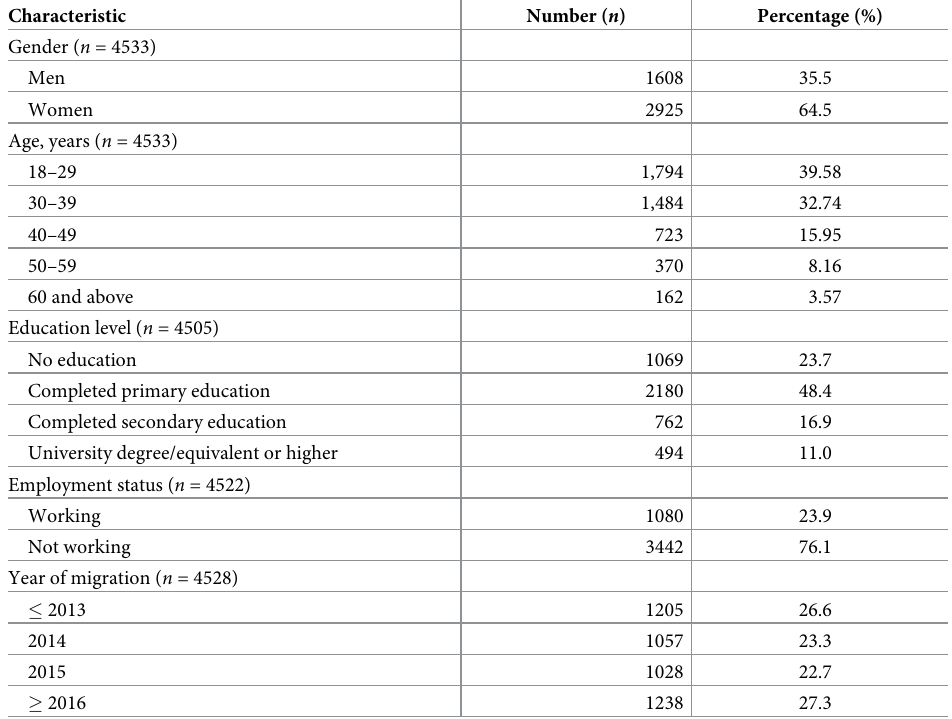
Table 2. Sociodemographic characteristics of